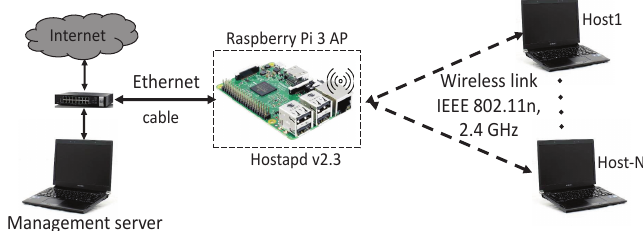
Figure 10. Testbed topology for Web